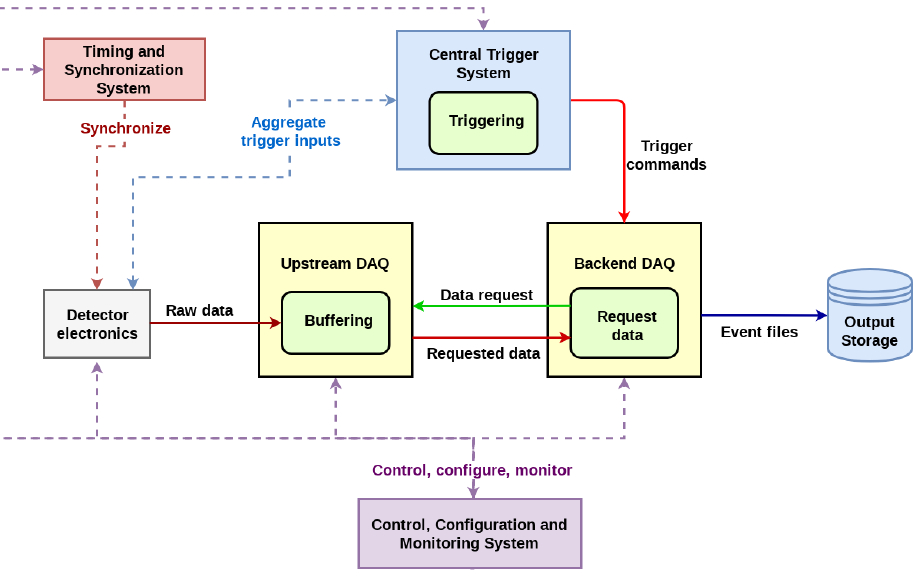
Figure 1. Overview of the ProtoDUNE-SP DAQ, highlighting the interfaces between di ff erent compo- nents and the flow of data in the